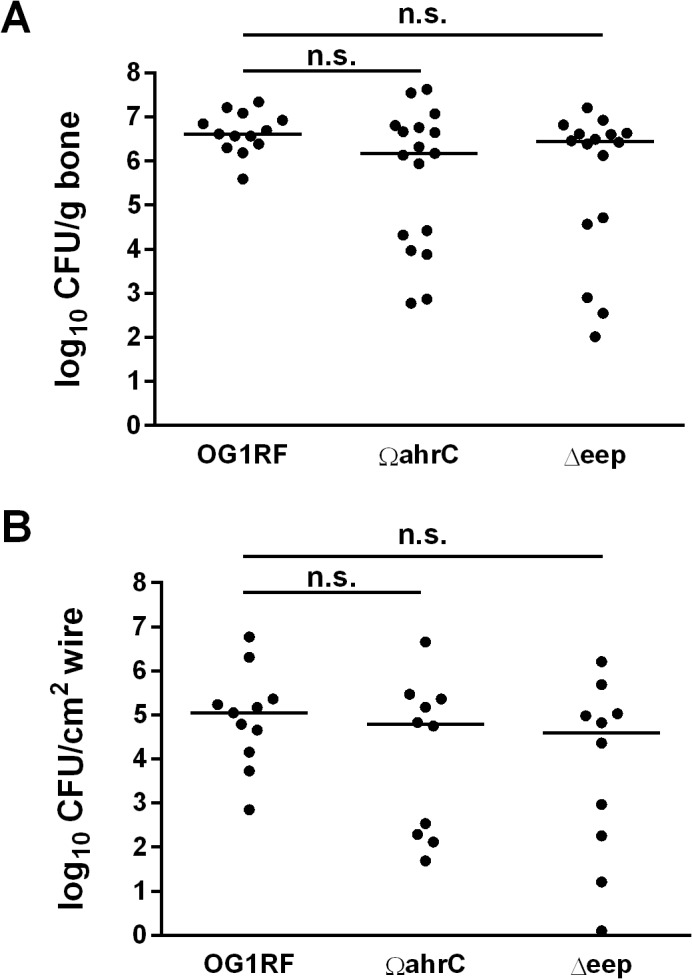
Quantitative bone (A) and wire (B) culture results from rats infected with E. faecalis OG1RF and gene disruption mutants ΩahrC and Δeep.Wires were submerged in bacterial cultures at a density of 1.0 McFarland for two hours prior to surgical implantation as described in the Methods section. Infections were carried out for one week. Bacterial loads are given as log10 CFU per gram of bone or cm2 of wire surface. Solid horizontal lines represent median values. The Wilcoxon rank sum test was used to compare the results of quantitative cultures in bone and wire between OG1RF and each of the mutants in (A) and (B). n.s., not significant. (A) OG1RF, n = 13; ΩahrC, n = 17; Δeep, n = 16. (B) OG1RF, n = 11; ΩahrC, n = 10; Δeep, n = 10. Wire counts were not performed on all animals shown in (A) due to their use in other (unrelated) studies.